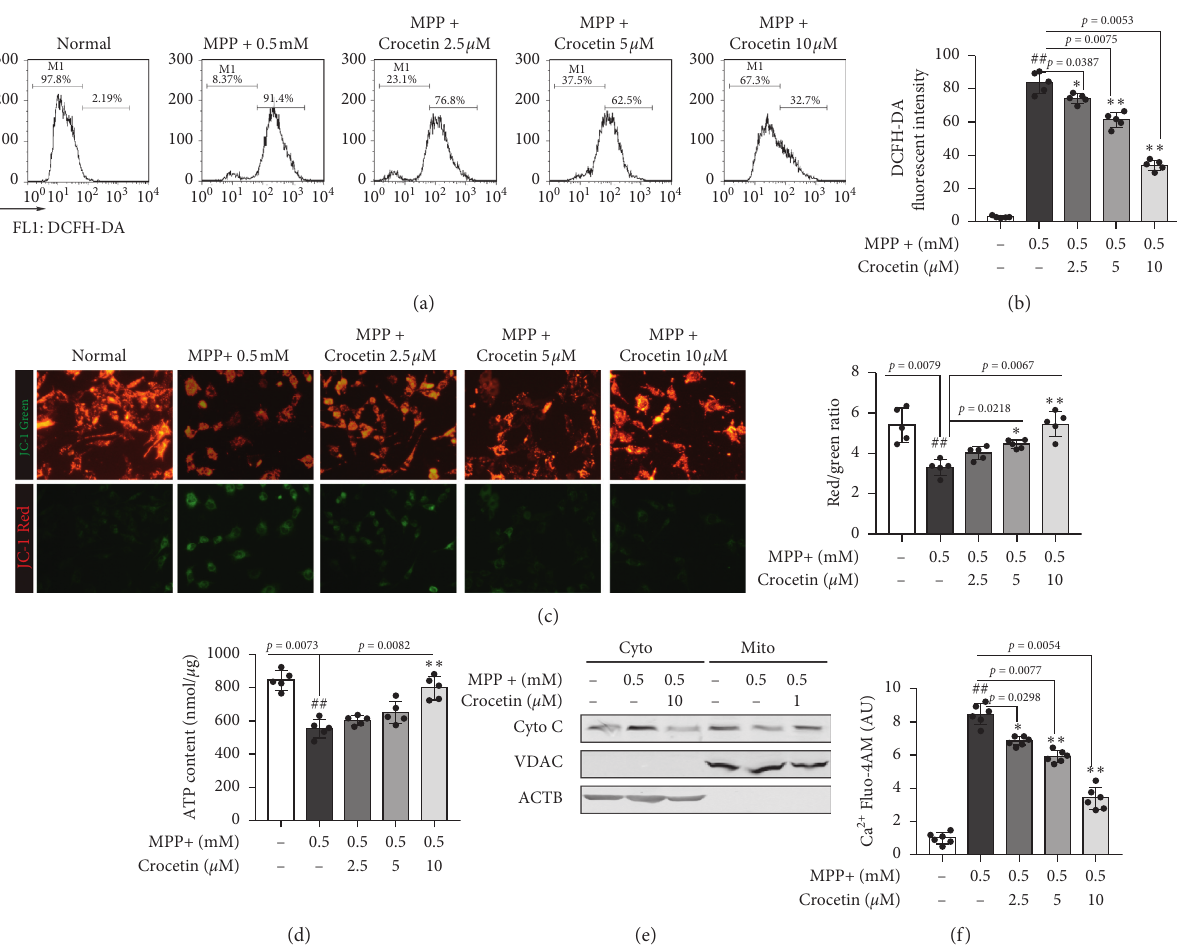
Figure 4: Crocetin improves mitochondrial dysfunctions in MPP+ -damaged BV2 cells. BV2 cells were treated with 0.5mM MPP+for 6h, and then 2.5 μ M, 5 μ M, and 10 μ M crocetin were added and incubated for another 24h. ((a), (b)) ROS was detected using DCFH-DA and measured by flow cytometer. (c) Mitochondrial membrane potential was measured using JC-1 dye and measured by a microplate reader. (d) Total ATP amounts in each group were measured. (e) The release of cytochrome c was measured between cytosol and isolated mitochondria. (f) The content of calcium in the cytosol was detected by Fluo-4AM and measured by a fluorescence microplate reader. Data are expressed as the mean ± standard deviation, and statistical analysis was performed using a one-way analysis of variance followed by Tukey’s post hoc test. ## P < 0 . 01 versus control; ∗ P < 0 . 05, ∗∗ P < 0 . 01 versus MPP+. n � 5 in each